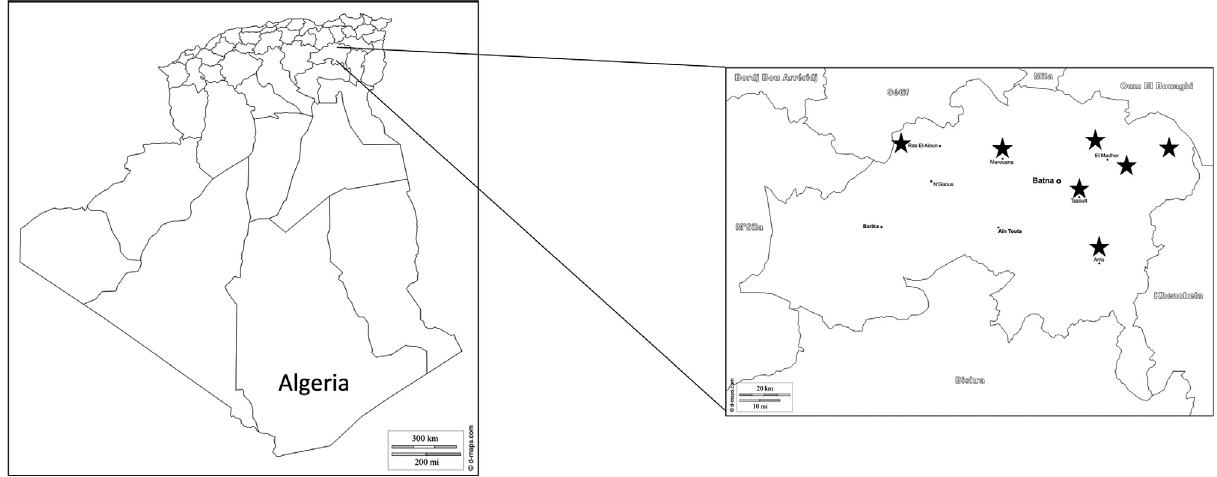
Figure 1. Map of Algeria and of the Batna province showing the location of the dairy farms investigated in this study. The original maps were downloaded from